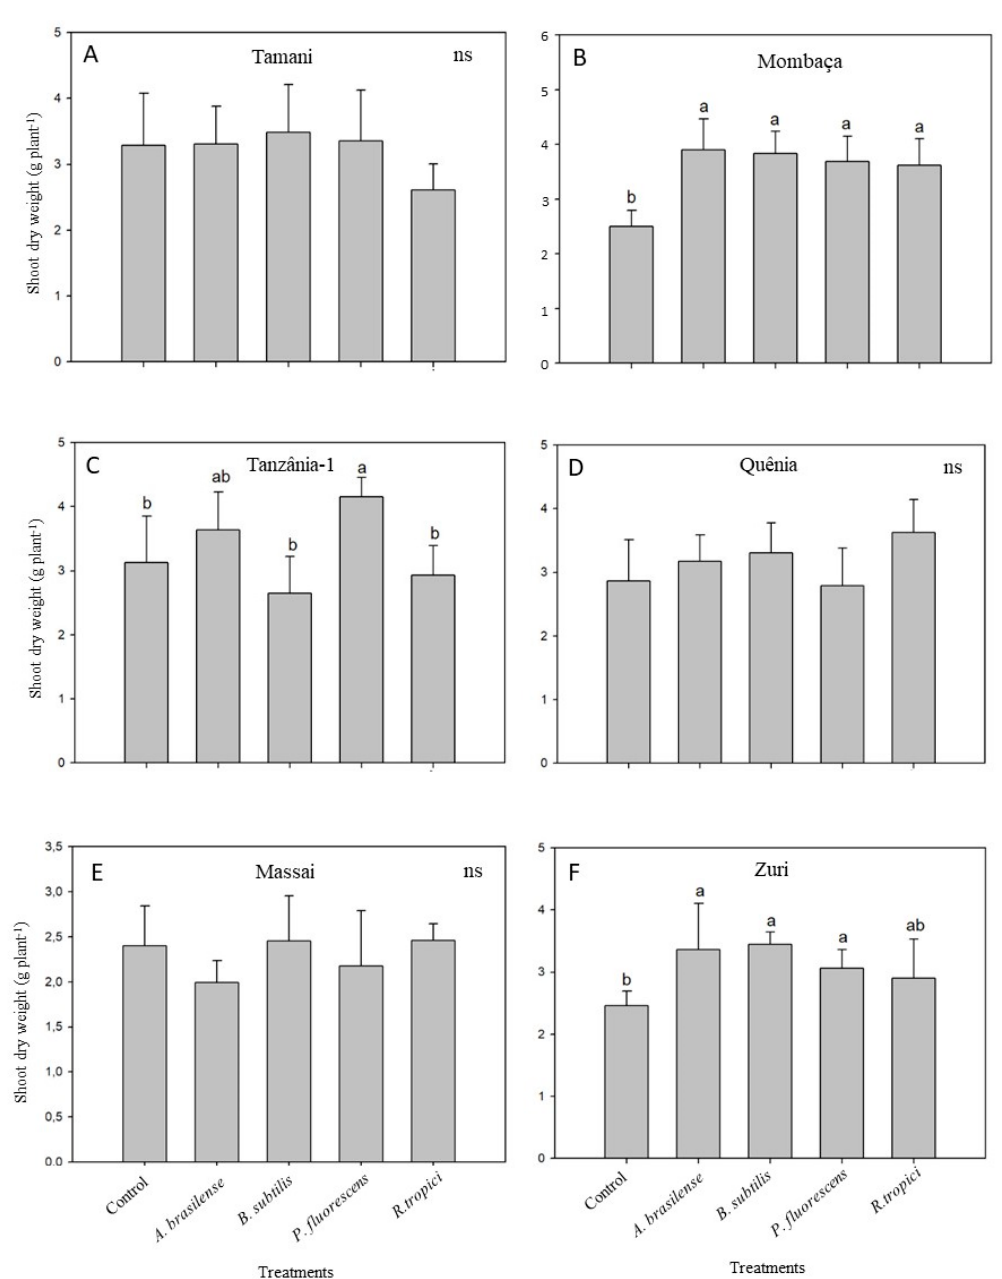
Figure 1. Shoot dry weight of six Megathyrsus maximus cultivars [Tamani ( A ), Mombaça ( B ), Tanzânia-1 ( C ), Quênia ( D ), Massai ( E ), and Zuri ( F )] either inoculated with Azospirillum brasilense (CNPSo 2083 + CNPSo 2084) , Bacillus subtillis (CNPSo 2657), Pseudomonas fluorescens (CNPSo 2719), or Rhizobium tropici (CNPSo 103), or remaining non-inoculated (Control). The experiment was carried out under greenhouse conditions in a sterile substrate and plants were sampled 35 days after emergence. Means (n = 6) followed by different letters differ from each other by the Duncan’s test at p ≤ 0.05.